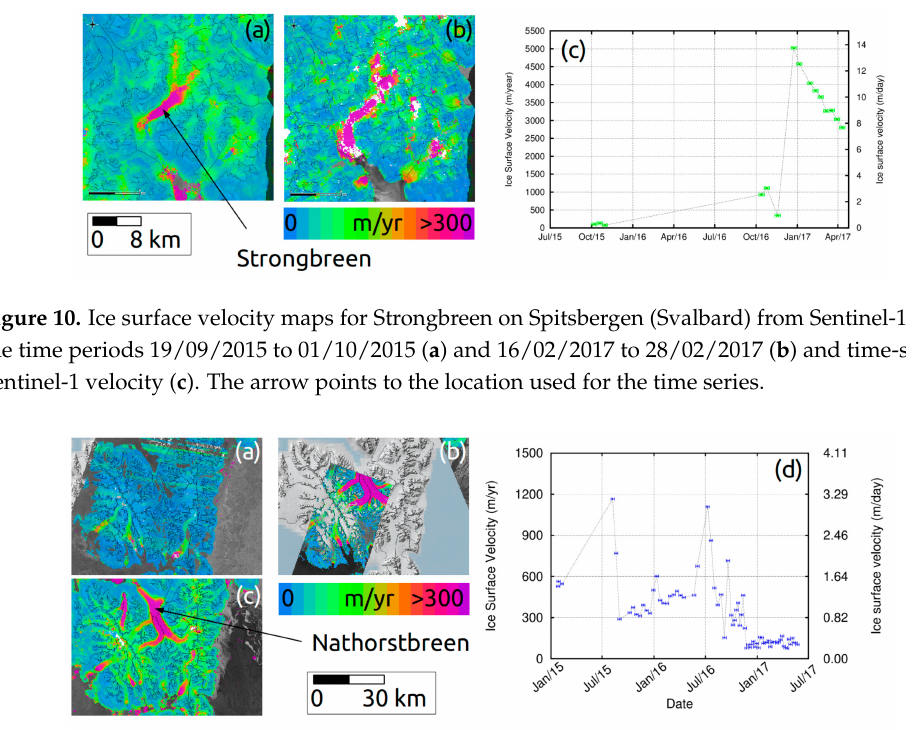
Figure 11. Ice surface velocity maps for Nathorstbreen on South Spitsbergen (Svalbard) from JERS-1 SAR in 1994 ( a ), TerraSAR-X in 2012 ( b ) and Sentinel-1 in 2015/2016 (average of winter data, ( c )) and Sentinel-1 time-series of velocity from 2015 to 2017 ( d ). The arrow points to the location used for the time